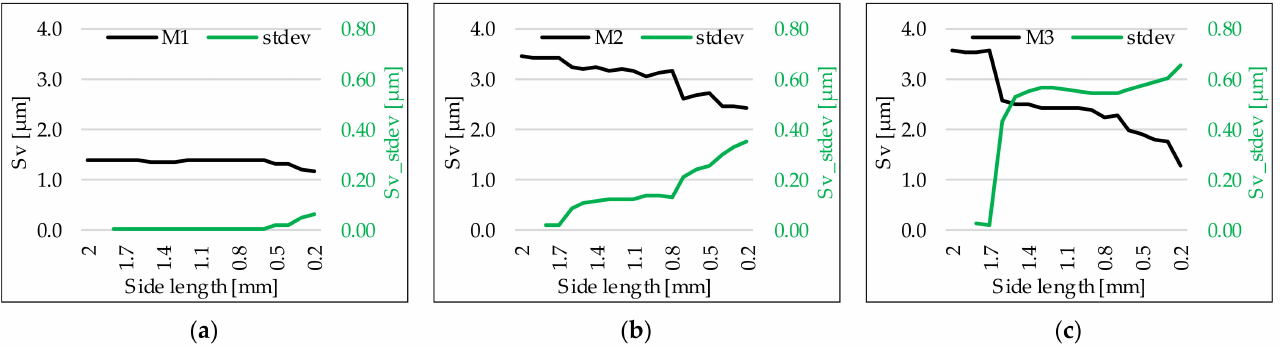
Figure 9. Sv parameters (black) and their standard deviations (green) as a function of the analyzed area (2 × 2 mm–0.2 × 0.2 mm): ( a ) M1—hard turning, f = 0.1 mm/rev; ( b ) M2—hard turning, f = 0.3 mm/rev; ( c )